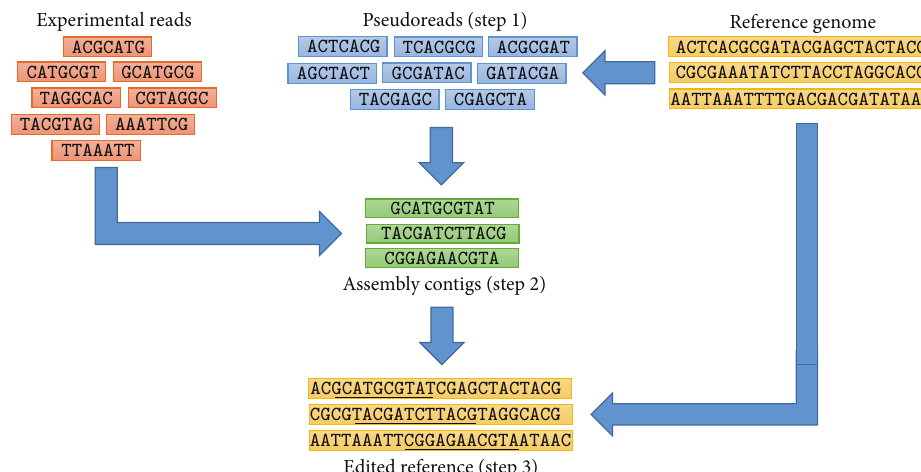
Figure 1: RECORD: Reference-Assisted Genome Assembly for Closely Related Genomes. The inputs of the pipeline, that is, the experimental reads and the reference genome, are illustrated in the top left and top right of the figure, respectively. Intermediate results produced in various steps of the analysis process are depicted. The dependency between these intermediate results is shown by arrows. In the illustration of the 3rd step, we underlined those segments of the edited reference which were replaced by one of the assembly contigs.